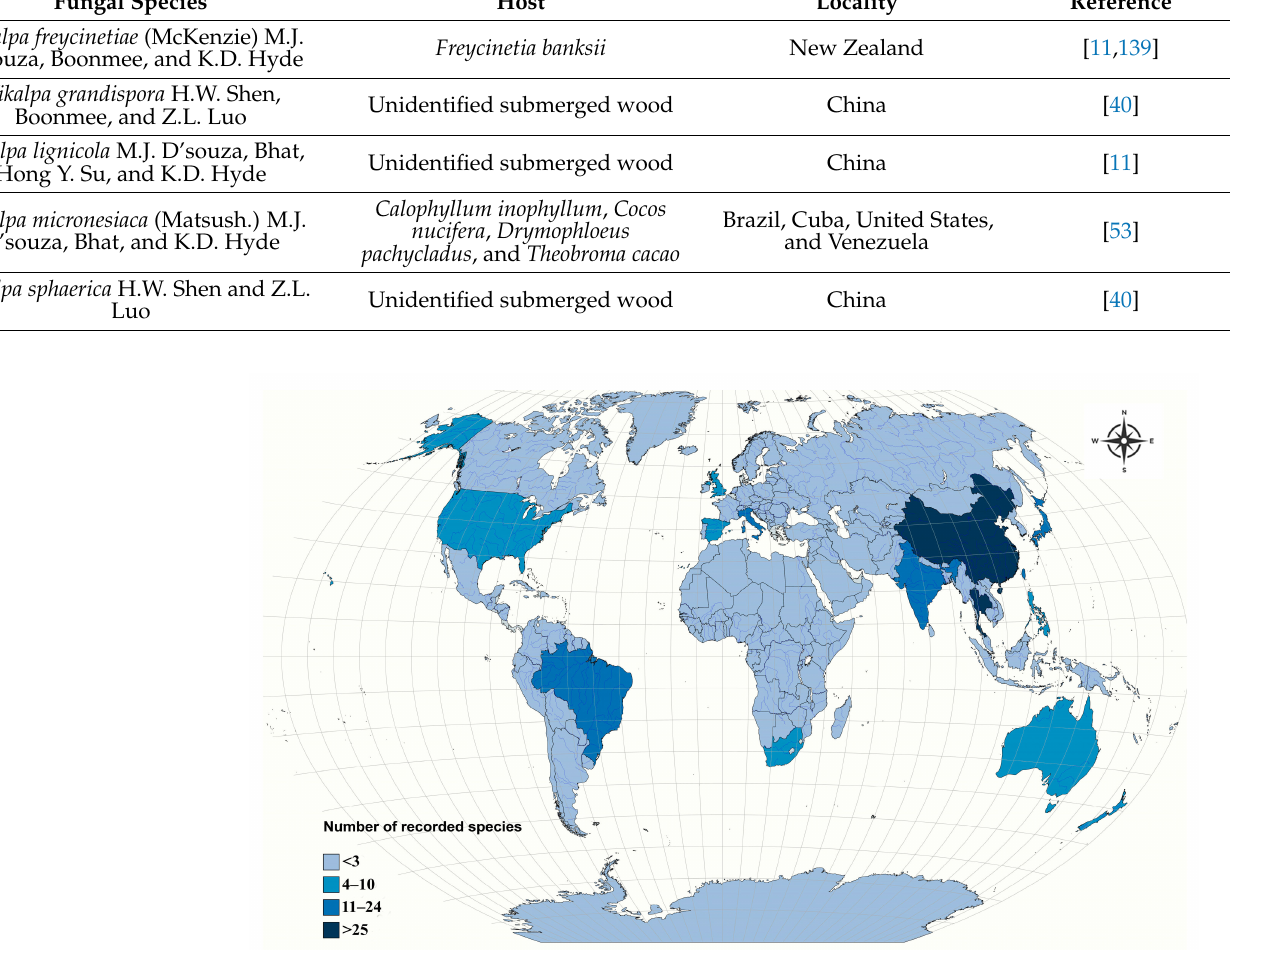
Figure 7. Distribution of so far reported Dictyosporiaceae species worldwide. Color gradient shows the number of recorded species from lowest (light blue) to highest (dark